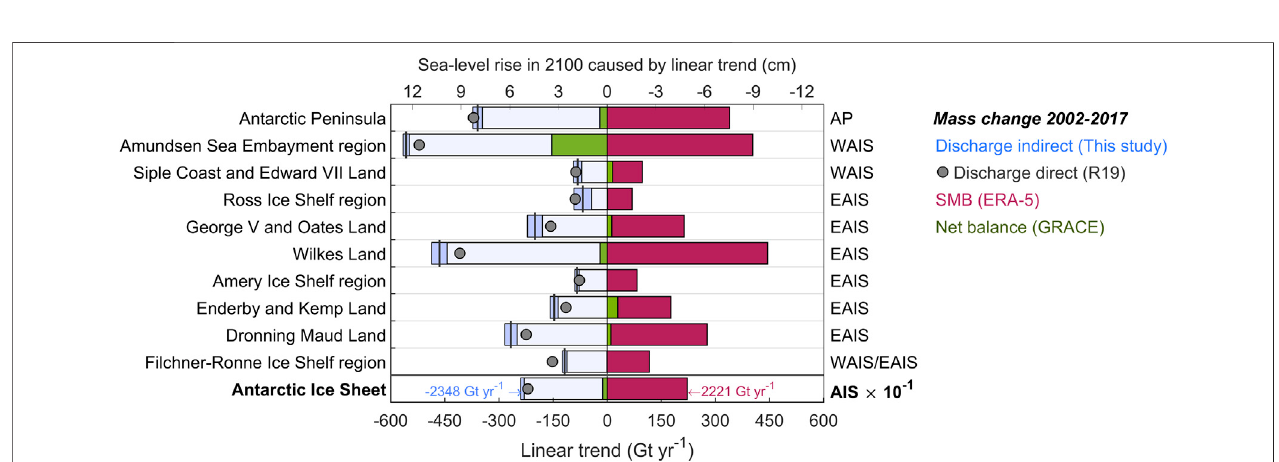
FIGURE 3 | Rate of mass change and its components for ten regions in Antarctica for 2002 to 2017. The rate of mass change, _ M , from GRACE/GRACE-FO (green) is decomposed into the mean rate of the cumulative surface mass balance (SMB), _ SMB , estimated from ERA-5 (red) and mean rate of cumulative discharge, _ D (blue), obtained by the difference between GRACE/GRACE-FO and the SMB component, along with its 1- σ uncertainties (darker blue). For comparison, grey circles indicatedirectestimatesoftherateofcumulativedischargeobtainedfromsurface-icevelocities(R19)(Rignotetal.,2019a).ValuesfortheentireAntarcticIceSheet are scaled by a factor of 10 − 1 for plotting. Rates of mass change are represented as Gt yr − 1 (bottom axis) and as integrated contribution to sea-level change by 2100 in cm (top axis). We assume 360 Gt of mass loss raise global mean sea level by 1 mm. Uncertainties for each component and the direct discharge estimate (Data availability) are shown in Supplementary Figure S5